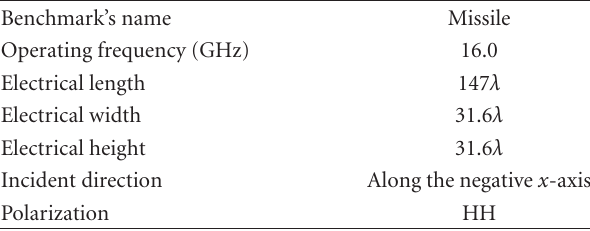
Table 6: Parameters of the simulated benchmark.